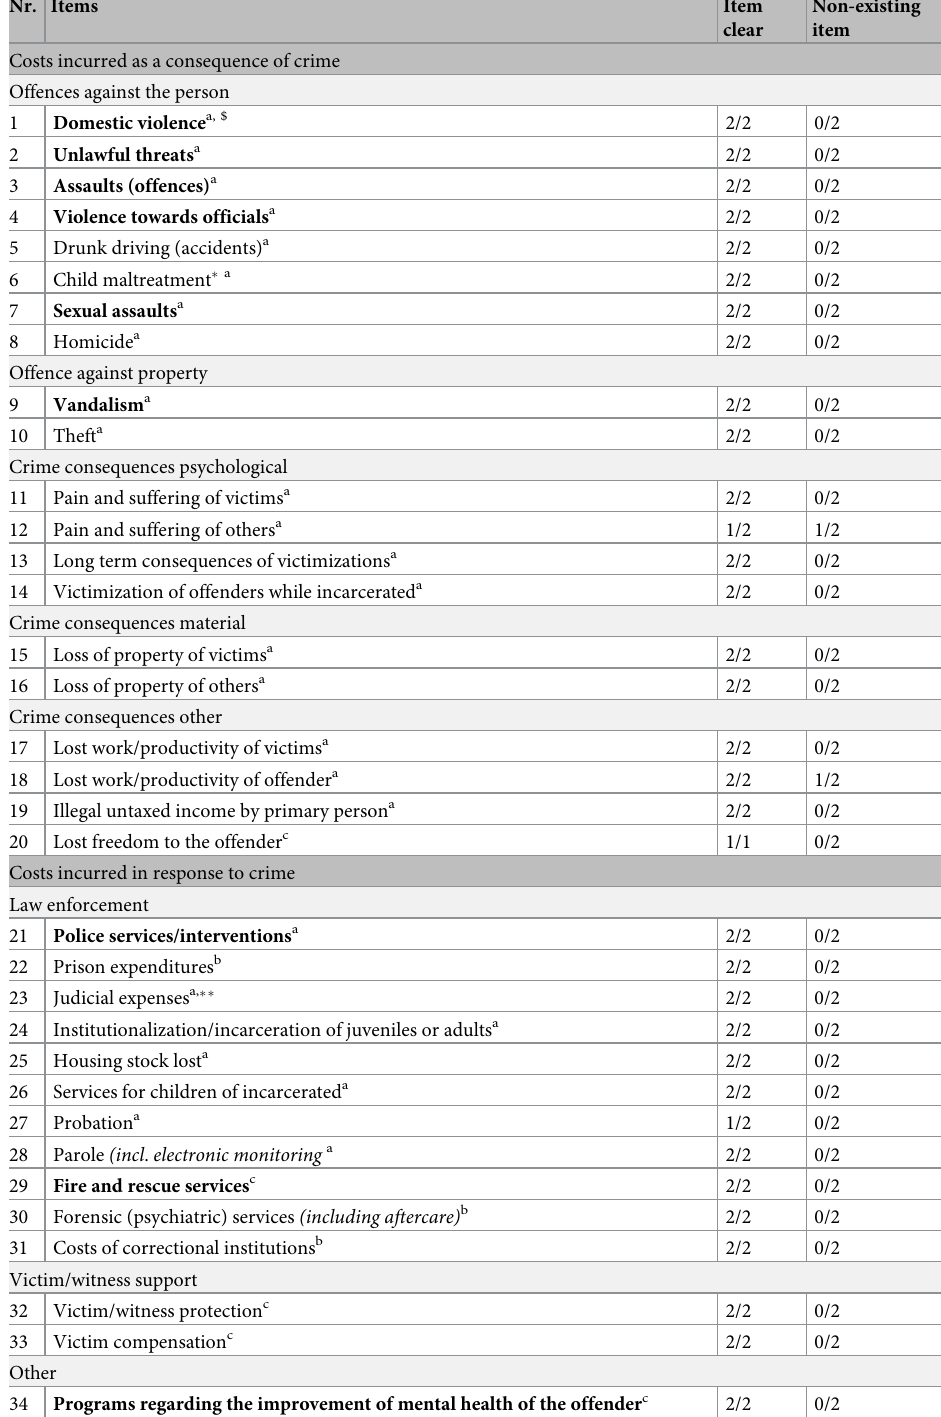
Table 3. Characteristics of items in the criminal justice sector (CJ) sector list, Austrian survey. Nr. Items Item